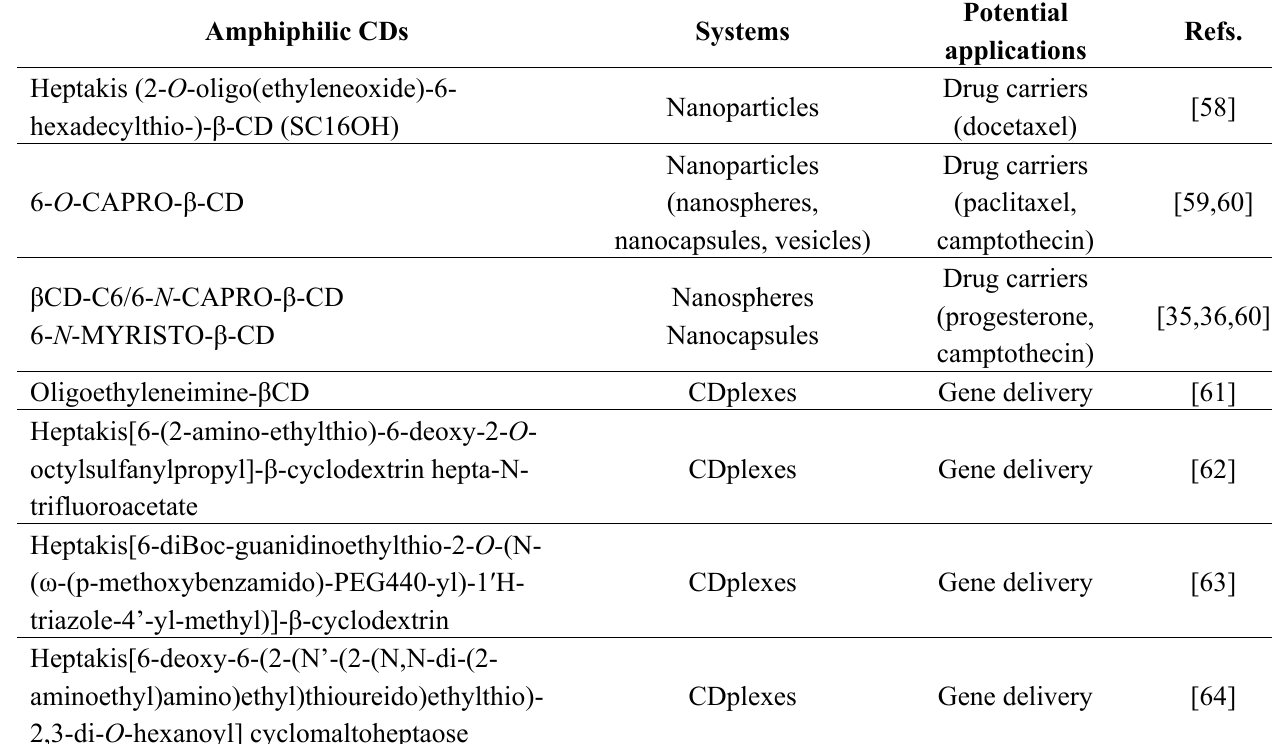
Table 3. Amphiphilic cyclodextrins derivatives and their potential application